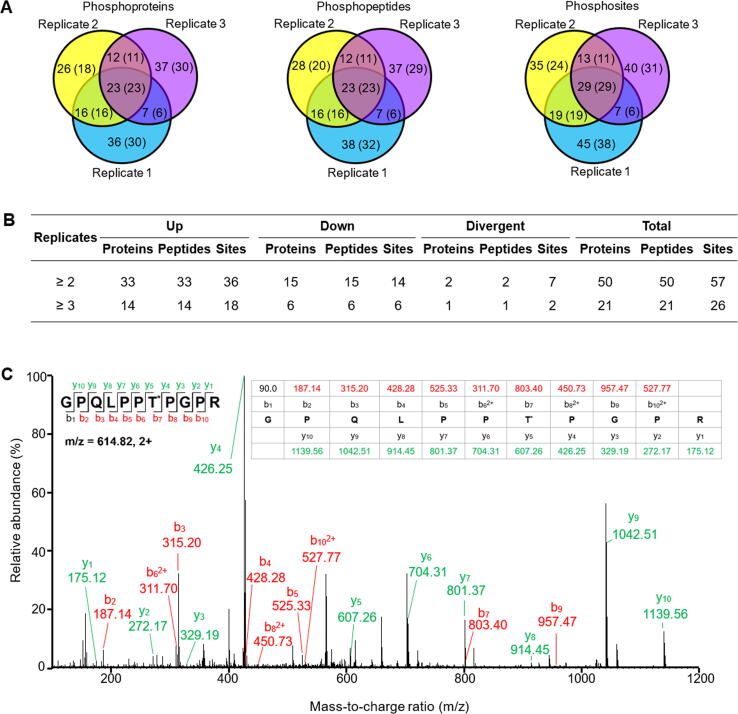
Summary of alkaligrass chloroplast phosphoproteomeA. Venn diagrams depicting overlap in phosphoproteins, phosphopeptides, and phosphorylation sites identified in three biological replicates. Number of quantified phosphoproteins, phosphopeptides, or phosphorylation sites is indicated in parentheses. B. Na2CO3-responsive phosphoproteins, phosphopeptides, or phosphorylation sites detected in at least two replicates. “Up” and “down” indicate that the phosphorylation level under treatment were increased and decreased when compared with the control, respectively. ‘Divergent’ indicates that the phosphorylation level increased under one treatment but decreased under the other, or indicates there are two more changed phosphorylation sites in one identified peptides; Pro, protein; Pep, peptide. C. Example of a representative MS/MS spectrum of phosphopeptides identified in the chloroplast phosphoproteome (fragmentation spectrum shown of m/z 614.82, +2, dimethyl-labeled, Accession No. EMT19581 of NCBI green plant database); Asterisk (*) represents the phosphorylation site.